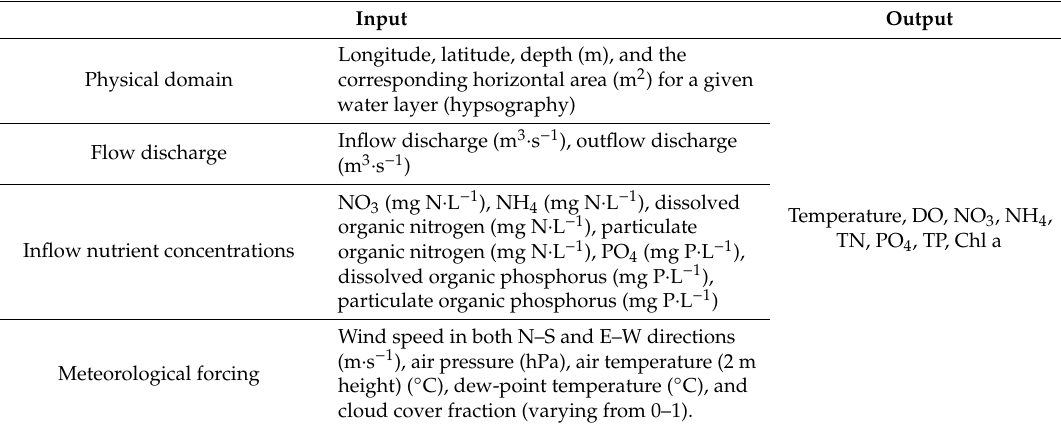
Table 1. The input and some selected output of the